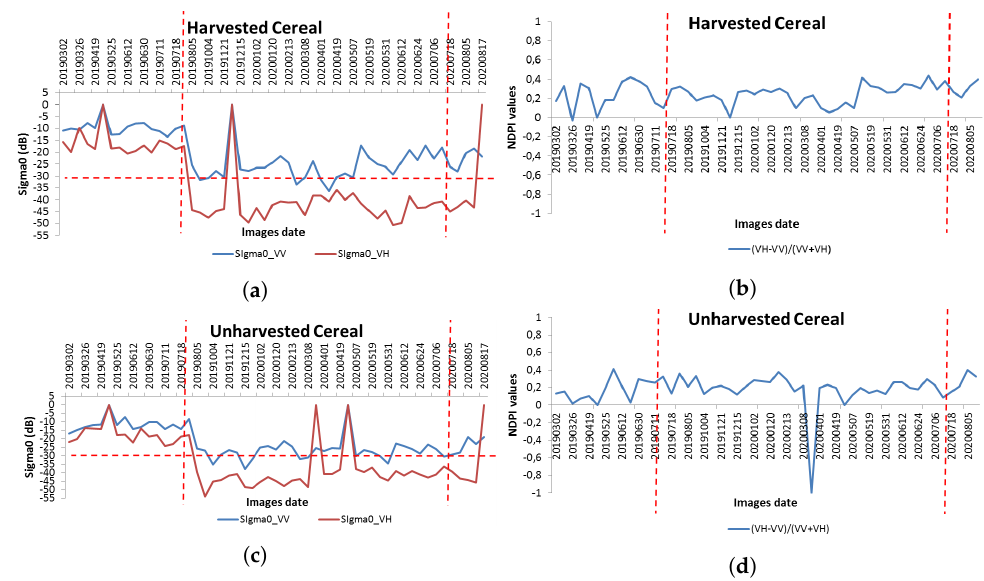
Figure 10. Time series of various covers. ( a , b ) Harvested Cereal. ( c , d ) Unharvested